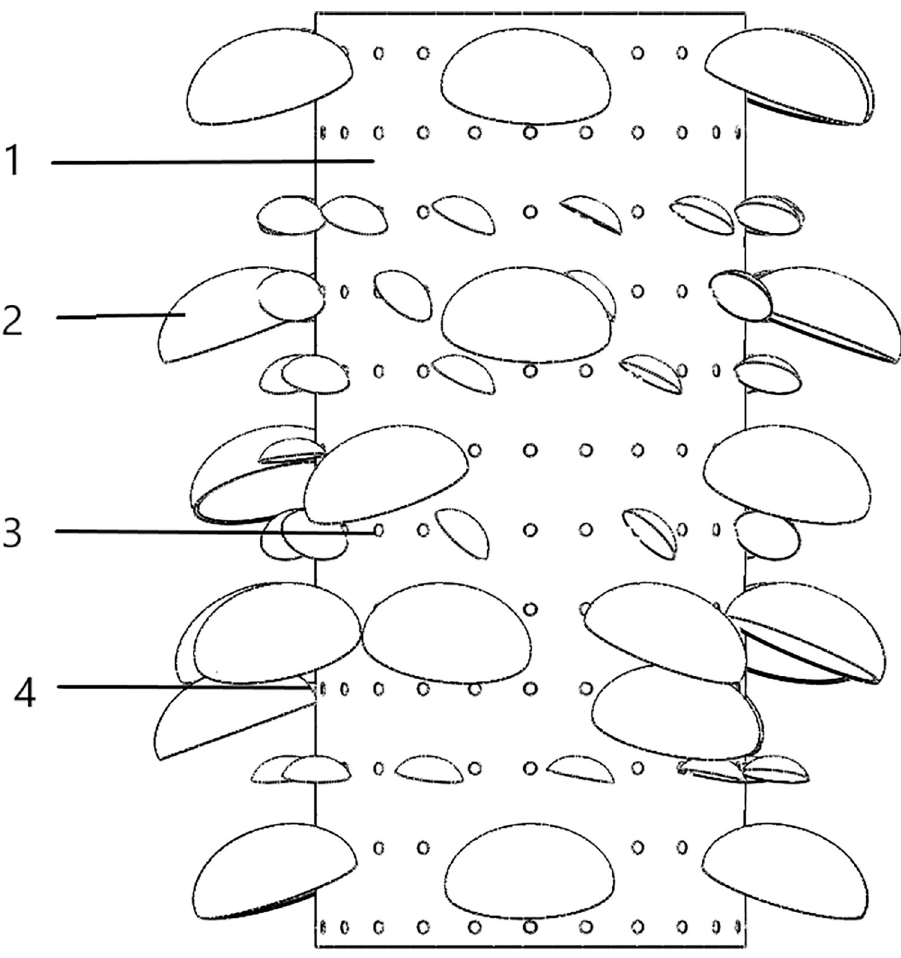
Fig 1. Model of black fungus leaves, puncture holes and black fungus sticks. 1. Black fungus sticks 2. Black fungus leaves 3. Puncture hole 4. the base of the black fungus leaves.